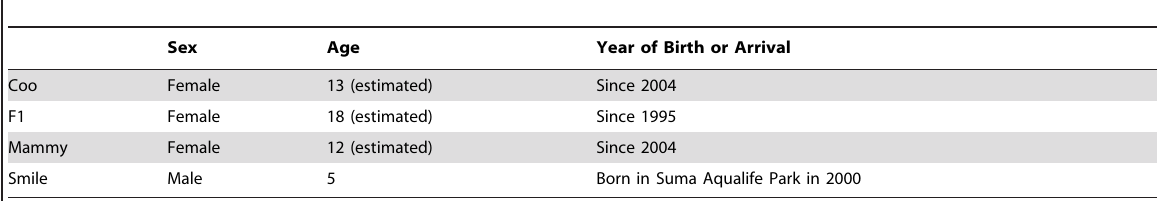
Table 1. Sex, age, and year that dolphins were born or year of arrival.